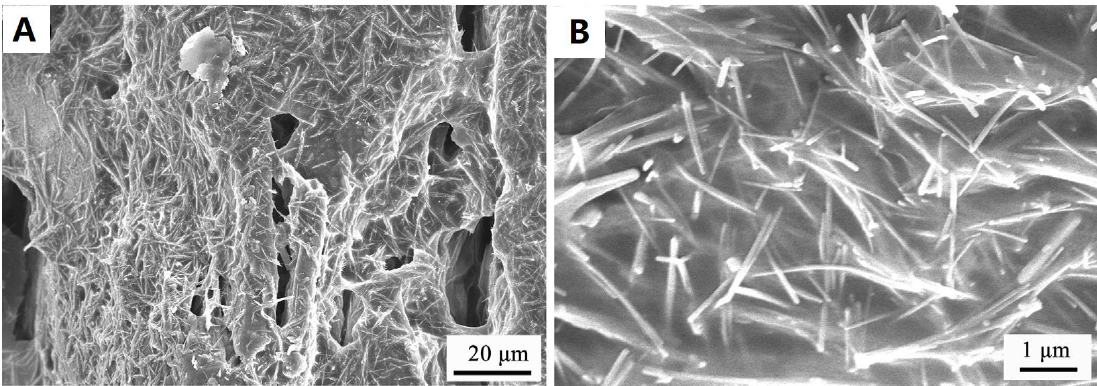
Figure 13. SEM images of polyethylene glycol (PEG)–Ag / expended vermiculite (EVM) shape-stabilized composite PCMs (ss-CPCM) containing 19.3 wt.% of AgNWs with scale bar of ( A ) 20 µ m and ( B ) 1 µ m [79].